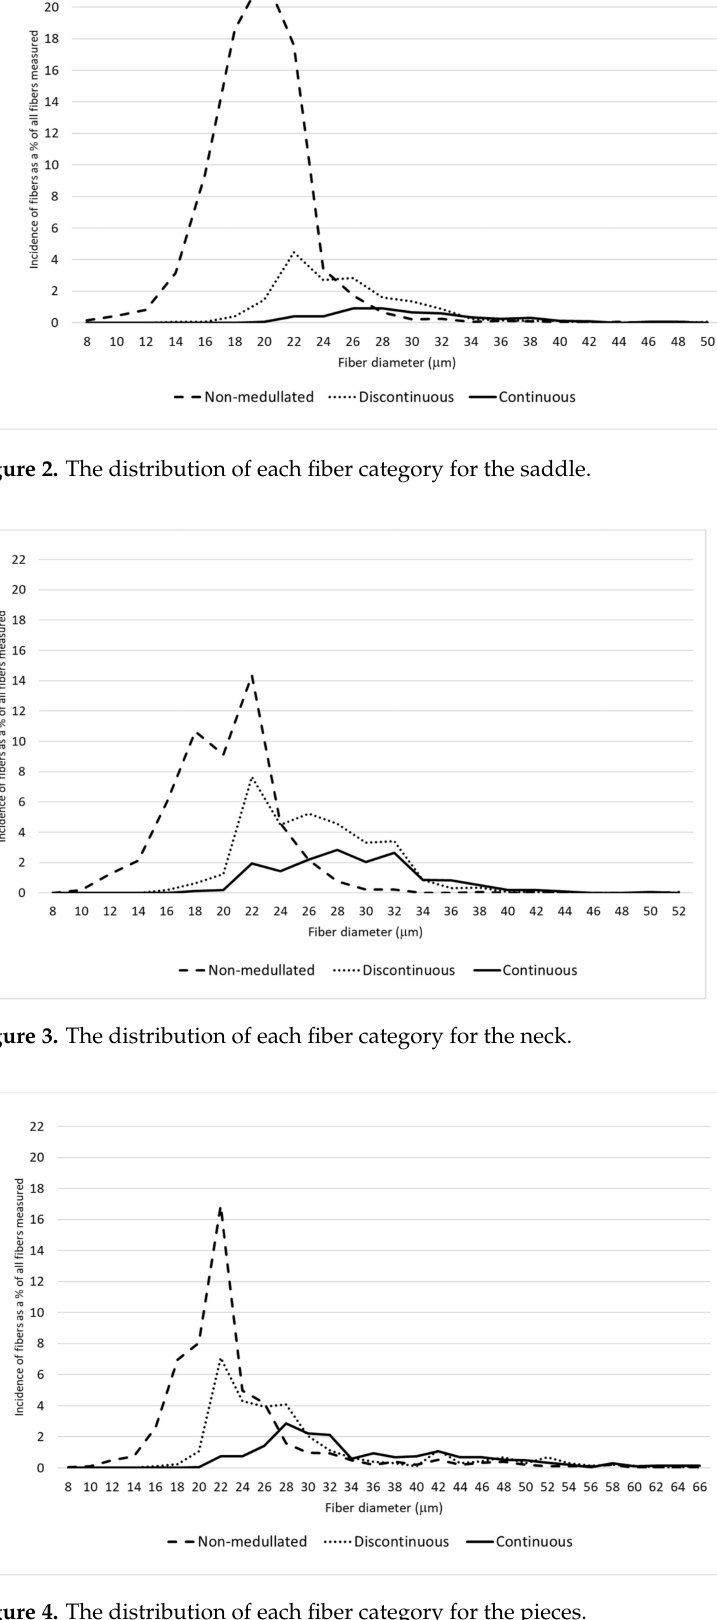
Figure 4. The distribution of each fiber category for the